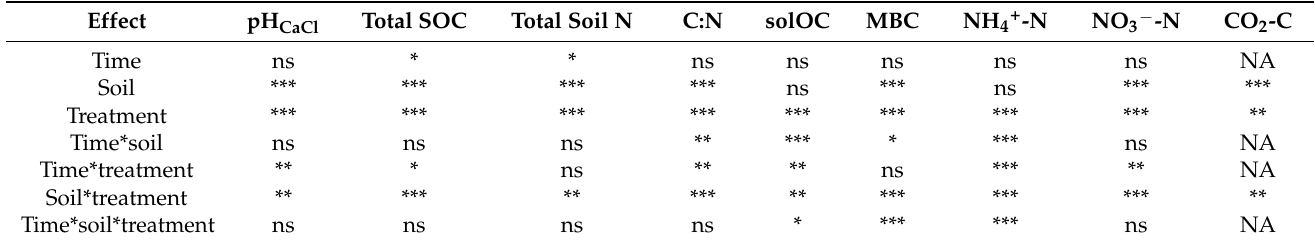
Table 1. Significant parameters of main and interaction effects for soil properties and basal soil